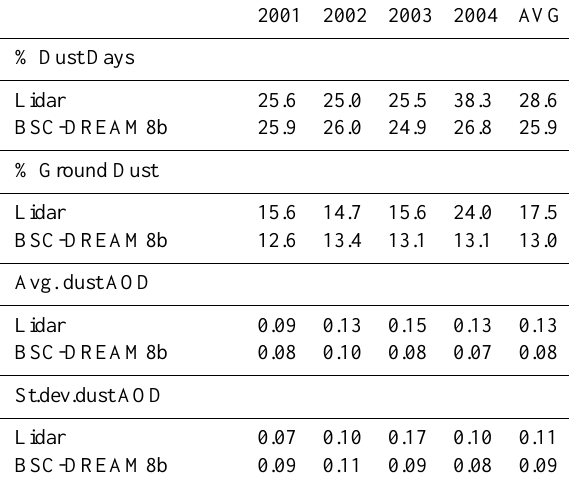
Table 2. Percent of advection days, ground contacts, average 532nm optical depth and relevant standard deviation of Saharan dust events as observed by the VELIS Lidar and forecast by BSC-